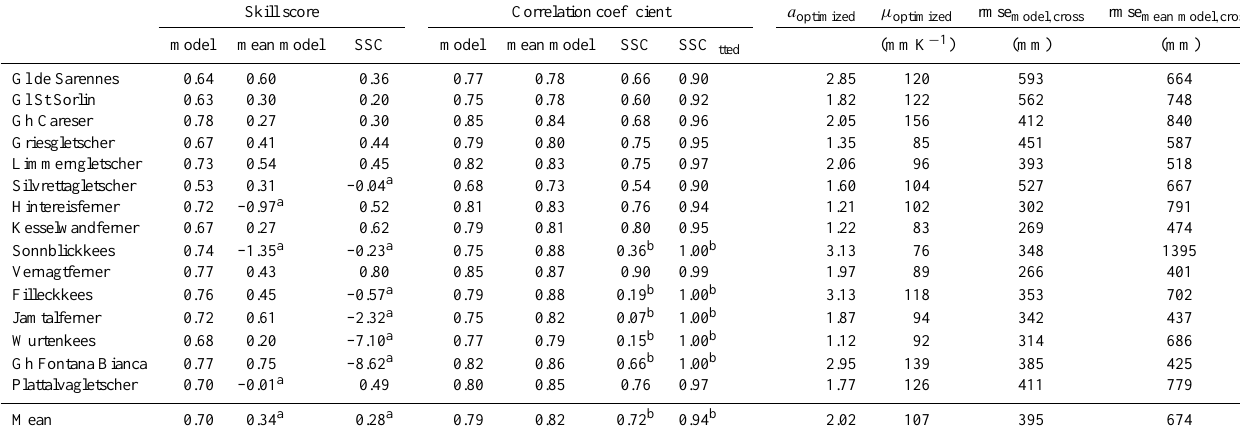
Table 1. Summary of skill scores, correlation coefficients, and parameters of the different models. The column SSC fitted shows the correlation coefficient of the SSC model when derived from the fitted model results instead of the cross validation.